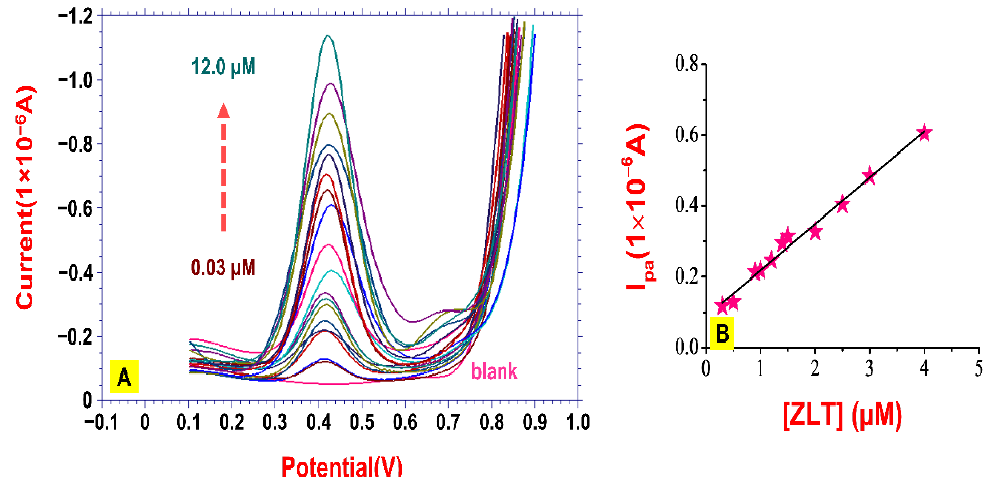
Figure 5. Influence of concentration of ZLT. ( A ) SWV responses of ZLT at different concentrations. ( B ) Plot of I pa versus concentration of ZLT. Table 1. A comparison of the proposed method with previously reported methods.